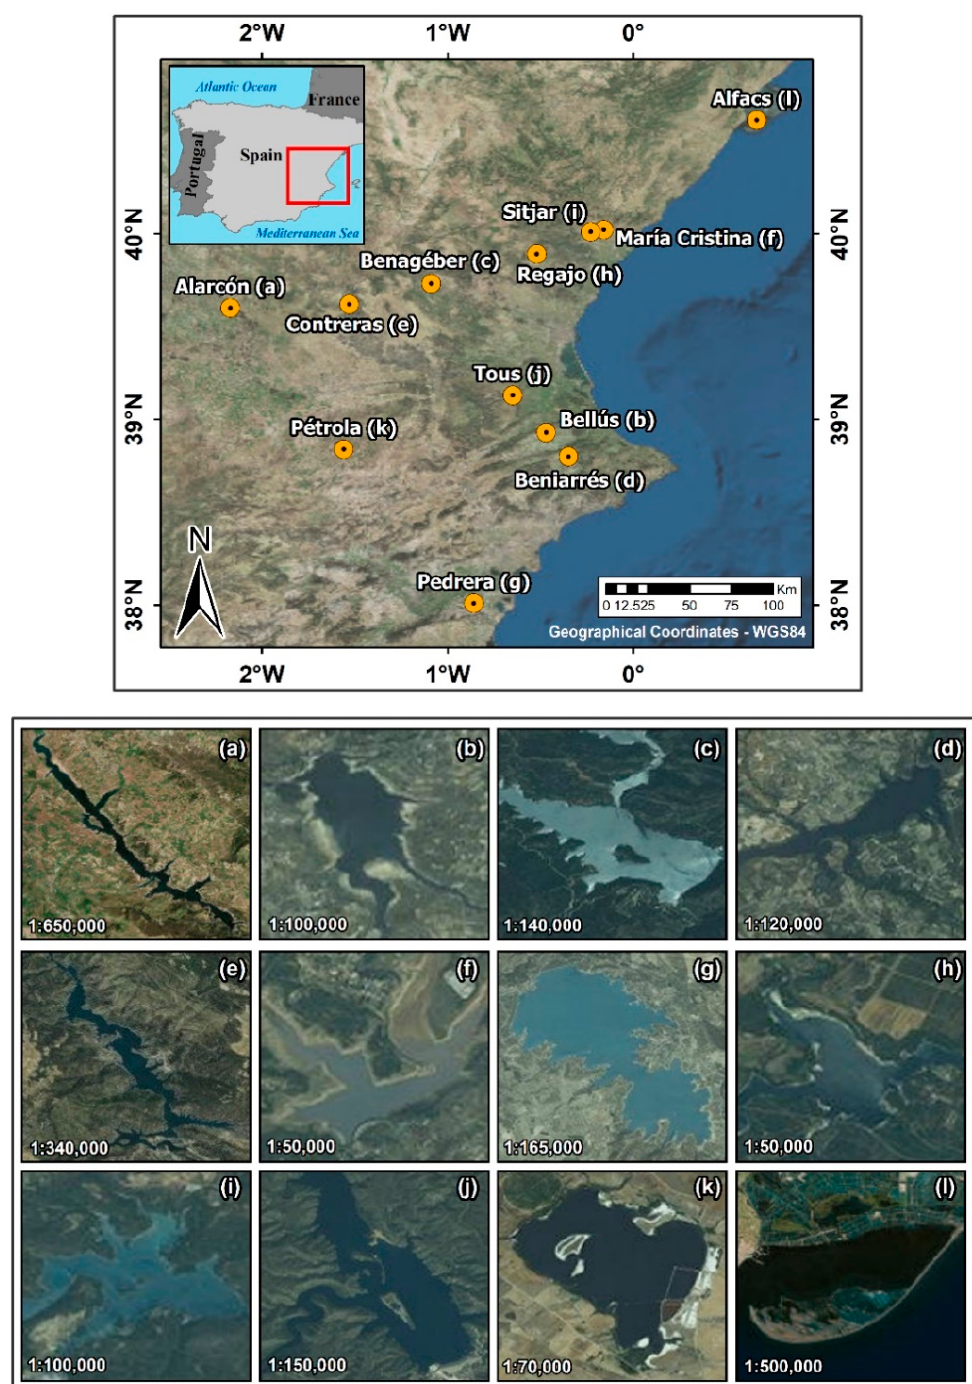
Figure 1. Study areas. Basemap source: Esri, DigitalGlobe, GeoEye, Earthstar Geographics, CNES/AIRbus DS, USDA, USGS, AeroGrid, IGN, and GIS User community.